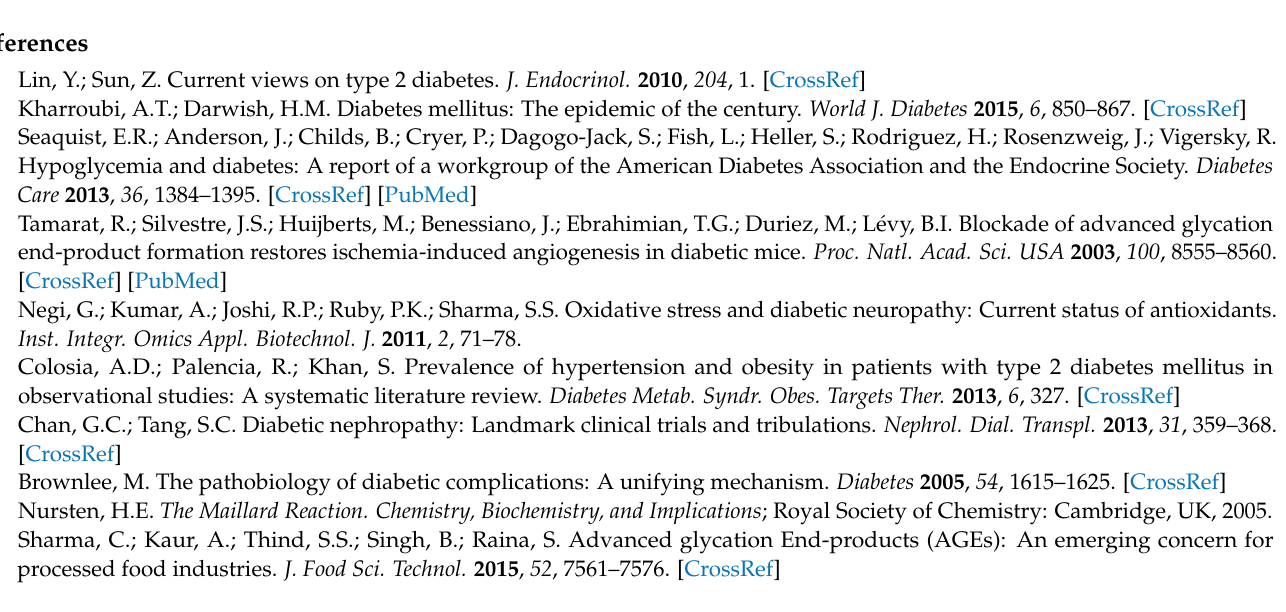
major constituents. Figure S1. Structure of test compounds. Figure S2. 3D H-bonding interac- tions of 2-phenyl isothiocyanate pose no. 1 [1], Apigenin pose no. 5 [2] caryophyllene oxide pose no. 1 [3] with binding sites of transcriptional regulator 1IK3. Figure S3. 3D H-bonding interactions of eugenol pose no. 3 [4], α -humulene pose no. 1 [5] with binding sites of transcriptional regulator 1IK3. Figure S4. 3D H-bonding interactions of quercitrin pose no. 4 [6] and caryophyllene pose no. 1 [7] with binding sites of transcriptional regulator 1IK3. Figure S5. 3D H-bonding Interactions of 2-phenylethylisothiocyanate pose no. 1 [8], apigenin pose no. 1 [9]; caryophyllene oxide pose no. 1 [10] with binding sites of transcriptional regulator 3TOP. Figure S6. 3D H-bonding interactions of eugenol pose no. 2 [11] and α -humulene pose no. 1 [12] with binding sites of transcriptional regu- lator 3TOP. Figure S6. 3D H-bonding interactions of quercitrin pose no. 4 [13] and caryophyllene pose no. 1 [14] with binding sites of transcriptional regulator 3TOP. Figure S7. 3D H-bonding interactions of 2-phenylethylisothiocyanate pose no. 1 [15], apigenin pose no. 3 [16] and caryophyllene oxide pose no. 1 [17] with binding sites of transcriptional regulator 4F5S. Figure S9. 3D H-bonding interactions of quercitrin pose no. 5 [20] and caryophyllene pose no. 1 [21] with binding sites of transcriptional regulator 4F5S